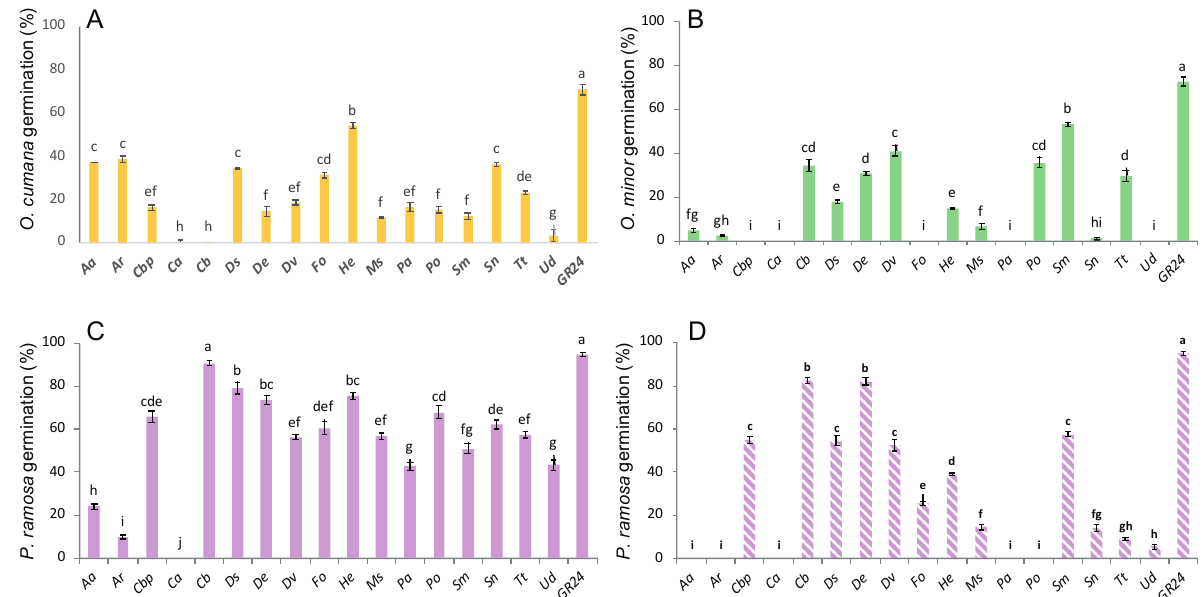
Figure 1. Mean seed germination proportions (%) of three broomrape species induced by organic extracts from roots of seventeen weed species, including Amaranthus albus L. (Aa); Amaranthus retroflexus L. (Ar); Cbp, Capsella bursa-pastoris (L.) Medik.; Ca, Convolvulus arvensis L.; Cb, Conyza bonariensis L.; Ds, Datura stramonium L.; De, Diplotaxis erucoides (L.) DC.; Dv, Diplotaxis virgate (Cav.) DC.; Fo, Fumaria officinalis L., He, Heliotropium europaeum L.; Ms, Malva sylvestris L.; Pa, Polygonum aviculare L.; Po, Portulaca oleracea L.; Sm, Silybum marianum (L.) Gaertn., Solanum nigrum L.; Tt, Tribulus terrestris Boiss.; Ud, Urtica dioica L.. Root extracts were applied at 100 μg (A-C) or 10 μg (D) of root organic extract per mL distilled water to seeds of Orobanche cumana Wallr. (A) , Orobanche minor Sm. (B) or Phelipanche ramosa (L.) Pomel . (C and D). For each broomrape species, means accompanied by different letters are significantly different according to the LSD test ( P < 0.05). Error bars represent the standard error of the